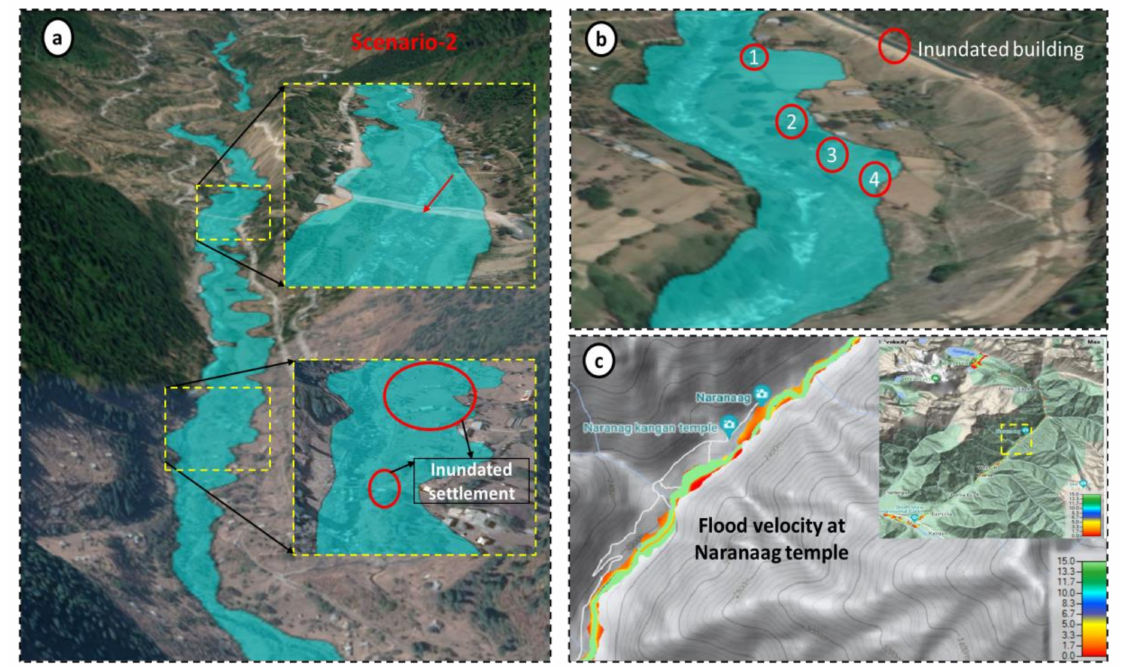
Figure 18. GLOF inundation modeled in scenario 2: ( a ) inundated settlement and bridge; ( b ) decrease in the inundated area at unnamed settlement in scenario 2; ( c ) flood velocity at Naranaag